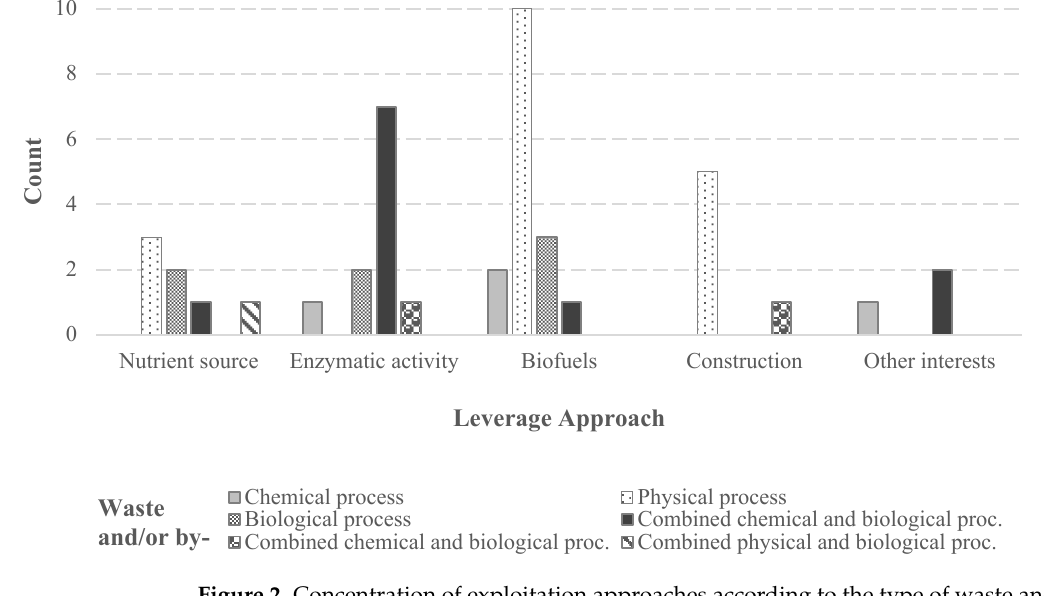
Figure 2. Concentration of exploitation approaches according to the type of waste and/or palm oil by-product.